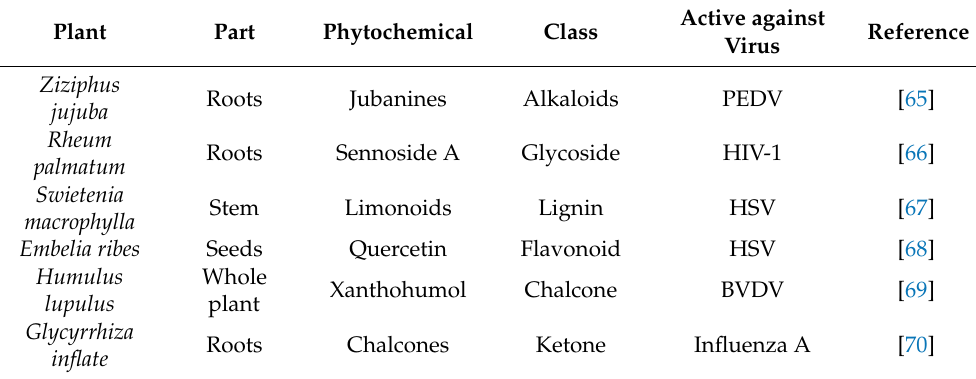
Active against Reference Virus